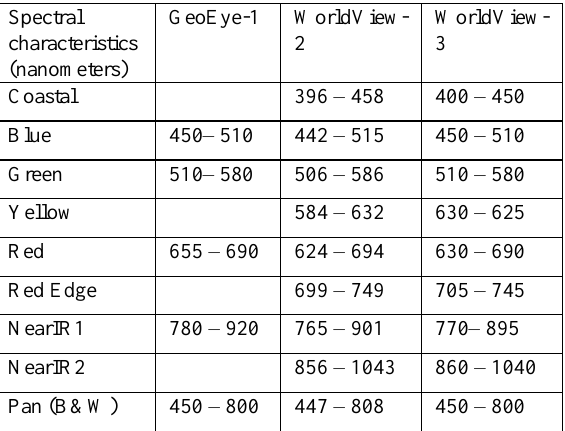
Table 1. Multispectral characteristics of utilized platforms (Digitalglobe, 2017)